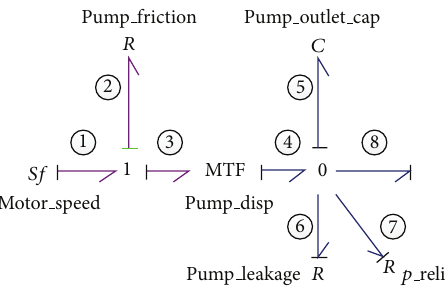
Figure 2: Bond graph model of the variable displacement pump.